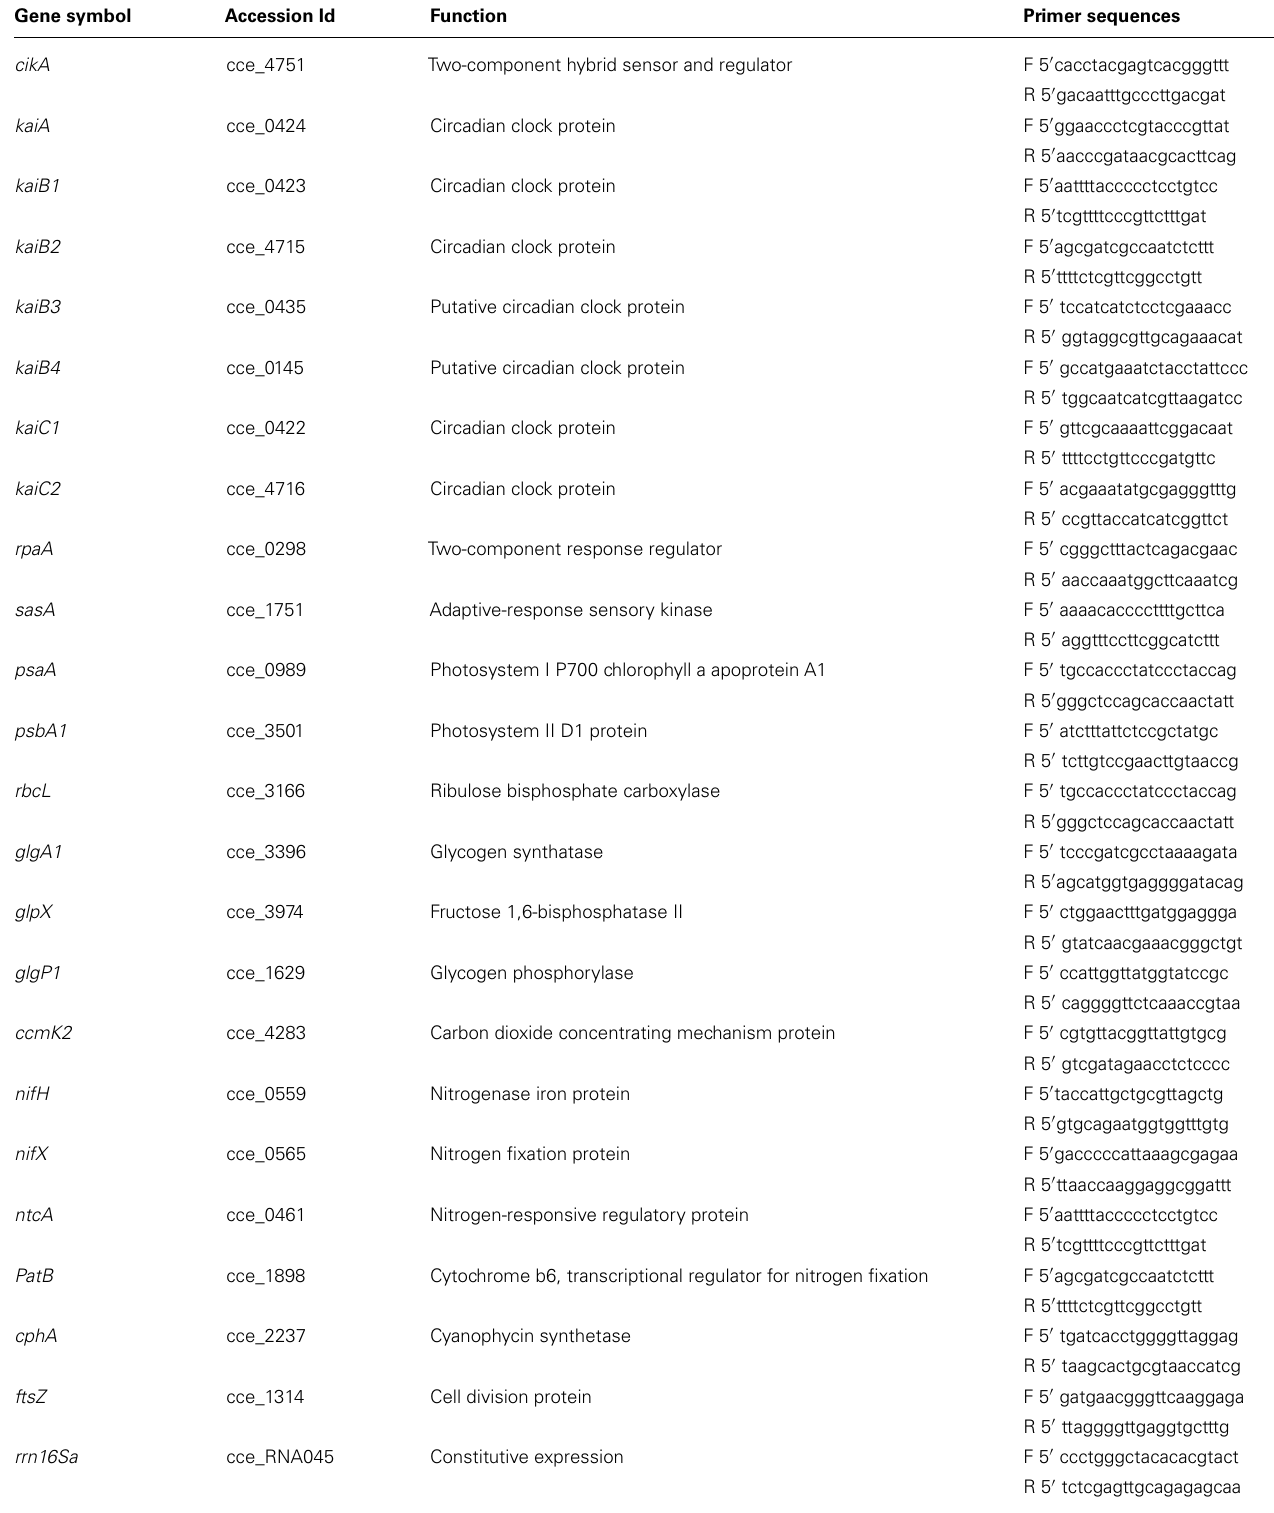
Table 1 | List of genes and the respective primer sequences used in the quantitative RT-PCR based gene expression